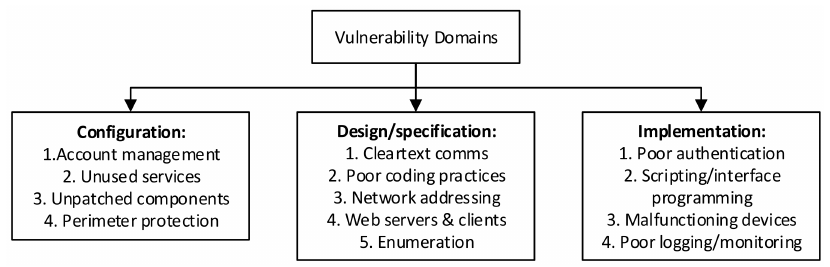
Figure 9. Vulnerability as an exploitable weakness